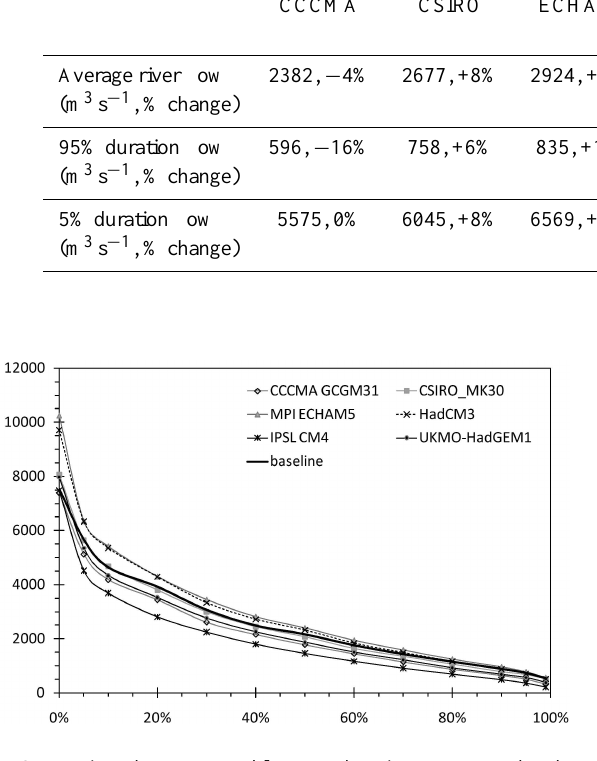
Fig. 8. Projected mean monthly flow duration curves under the A1b SRES emissions scenario from six priority GCMs in the Rio Grande basin along with the detrended 1961–1990 baseline or con- trol